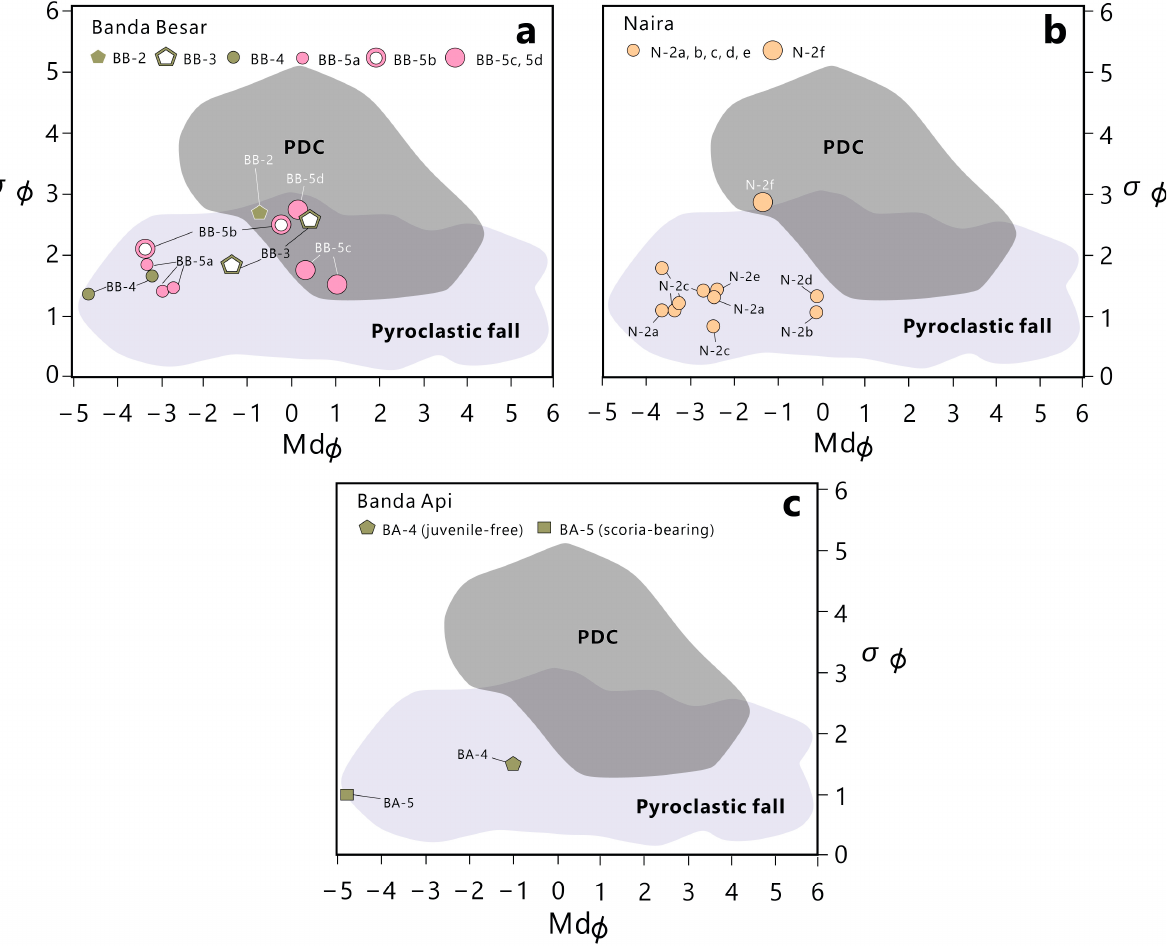
Figure 6. Median and sortation plot for Banda Besar ( a ), Naira ( b ), and Banda Api ( c ) pyroclastic deposits. Note that lapilli and ash-rich samples of BB-3 and BB-5b resulted from different mecha- nisms, fallout, and PDC,